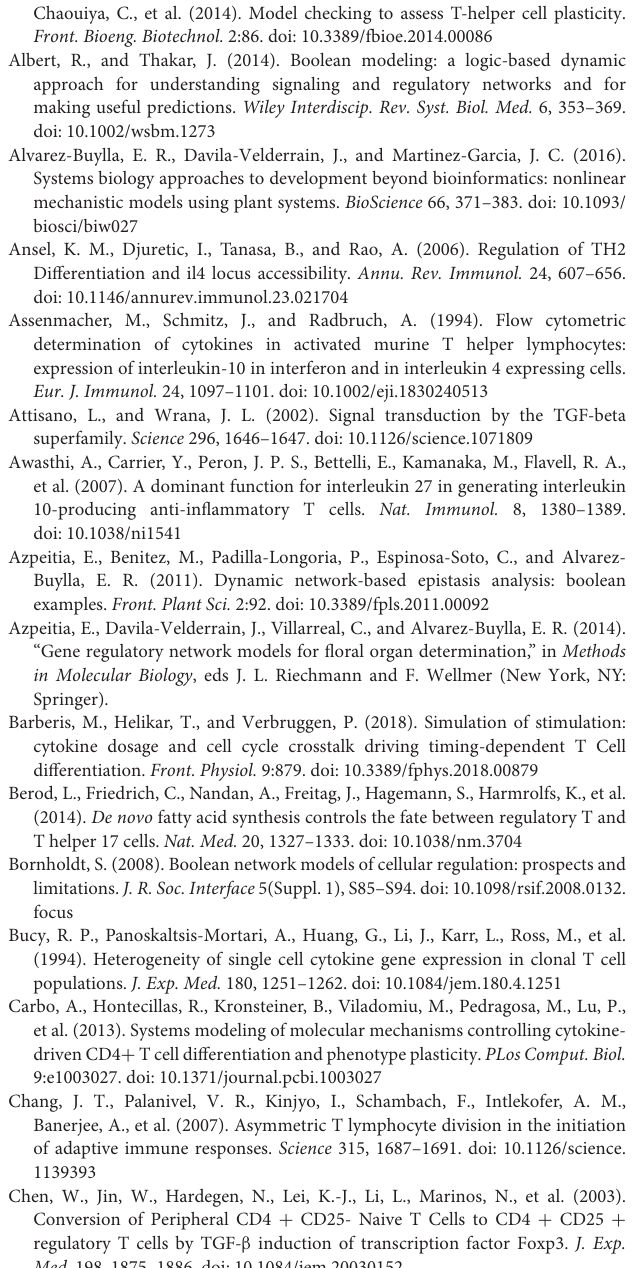
DATA SHEET S4 | Ordinary differential model equations of the CD4 + T cell regulatory network. DATA SHEET S5 | Boolean rules for labelling the attractors of the CD4 + T cell regulatory network. DATA SHEET S6 | Continuous attractors of the CD4 + T cell regulatory network. DATA SHEET S7 | Code and simulations of the CD4 + T cell regulatory